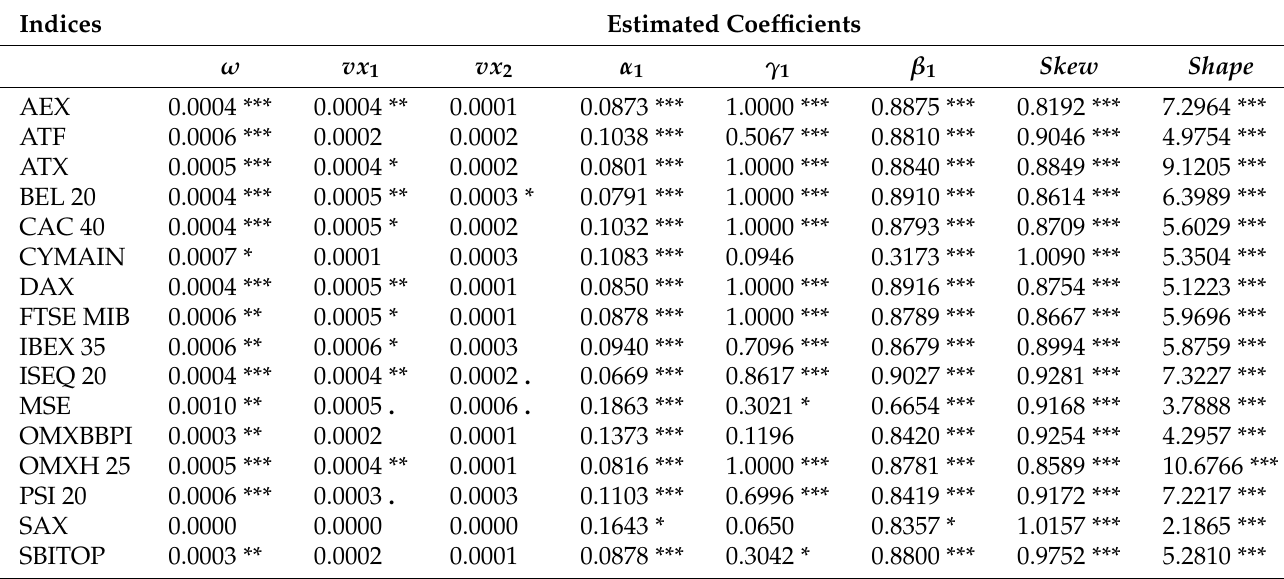
Table 1. Results of Conditional Volatility Equation.